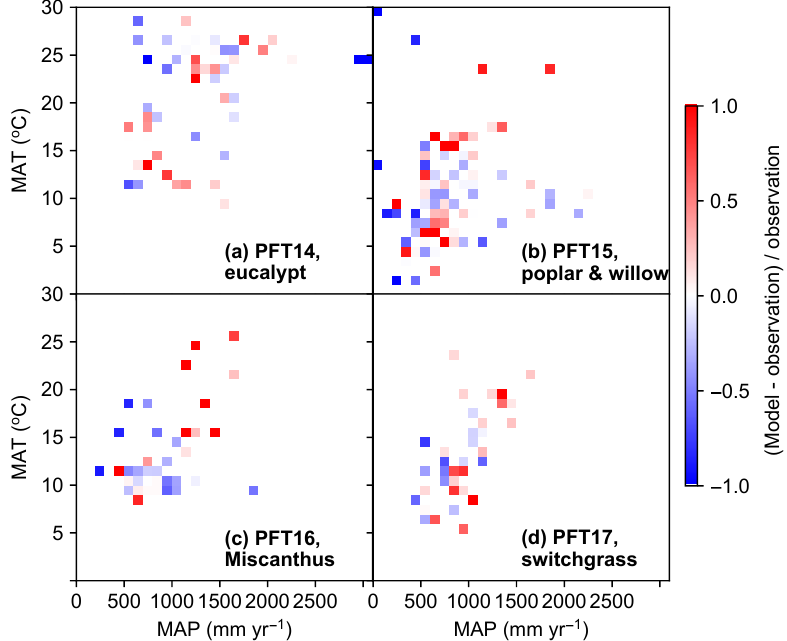
Figure 10. The relative difference between simulated and observed yield in different MAT and MAP intervals. The median values of model– observation differences of all grid cells in each MAT and MAP interval are shown. PFT14 is tropical bioenergy tree, eucalypt; PFT15 is temperate bioenergy tree, poplar and willow; PFT16 is C 4 bioenergy grass, Miscanthus ; PFT17 is C 4 bioenergy grass,